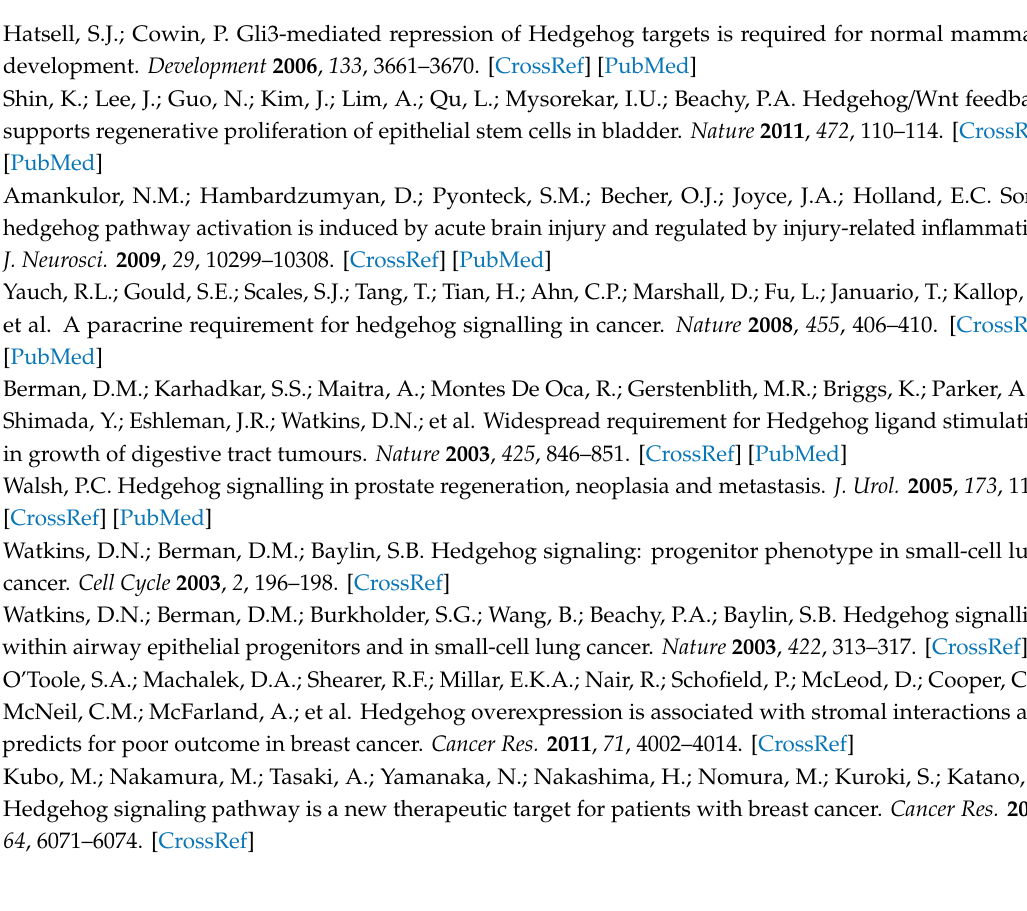
Figure S1: Full western blots of breast cancer cells, Figure S2: Full western blot of fibroblast cell lines and MCF10A Figure S3: E ff ect of SHH-ligand and Hh inhibitors in Luminal A and non-tumorigenic breast cancer cells, Figure S4: Characterization of mesenchymal markers and Hh signaling in fibroblasts, Figure S5: Primary cilium in fibroblasts, Figure S6: Proliferation of ER + tumor cells in co-culture with HMF, Figure S7: Hh signaling in NIH3T3 across culture modalities, Figure S8: Proliferation of NIH3T3 and Hs578t cells in tumor co-cultures, Figure S9: Characterization of Hh components in